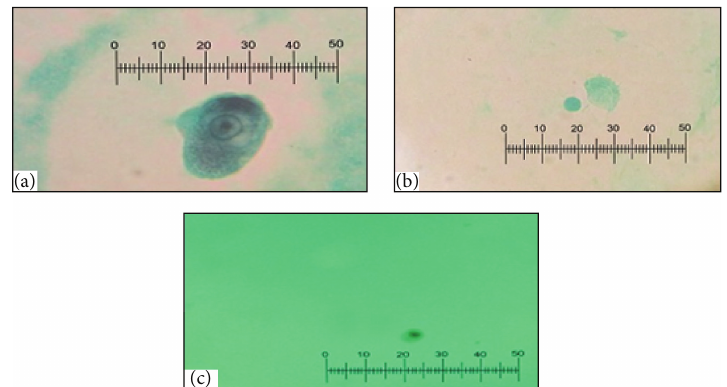
Figure 2: Protozoa in stool samples of the rodents, stained with trichrome. (a) Entamoeba trophozoite, (b) Trichomonas trophozoite, and (c) Endolimax trophozoite (100x).